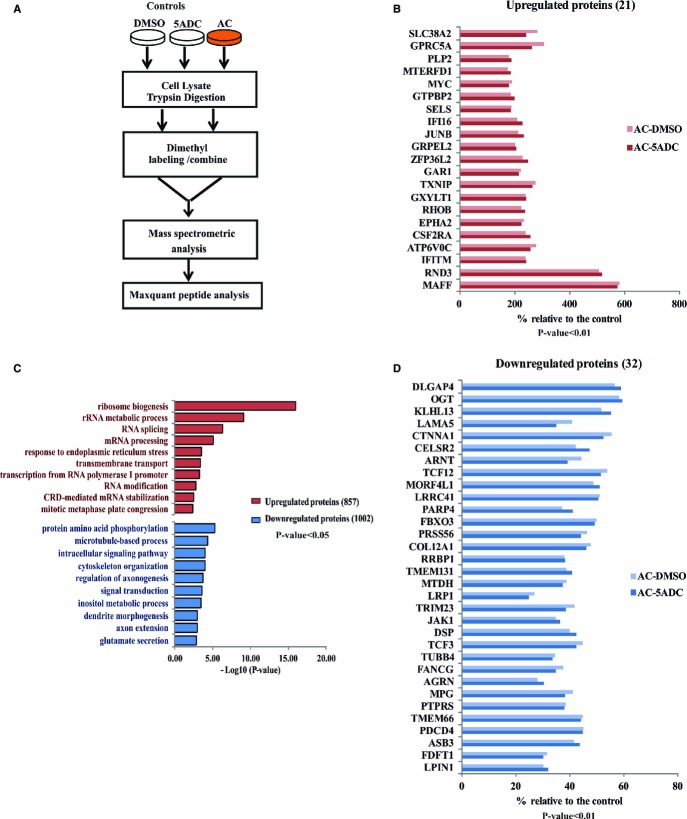
Quantitative mass spectrometry reveals candidate proteins including MYC to be induced by
5-azacytidine treatmentSchematic representation of experimental setup followed for quantitative mass spectrometric
analysis.Graphical representation of gene ontology studies performed on the proteins upregulated or
downregulated upon 5-azacytidine treatment with a
P-value < 0.05.Bar diagram showing genes upregulated upon 5-azacytidine treatment with a
P-value < 0.01. Data represents the average of two
replicates.Bar diagram showing the list of genes downregulated upon 5-azacytidine treatment with
value < 0.01. Data represent the average of two replicates.